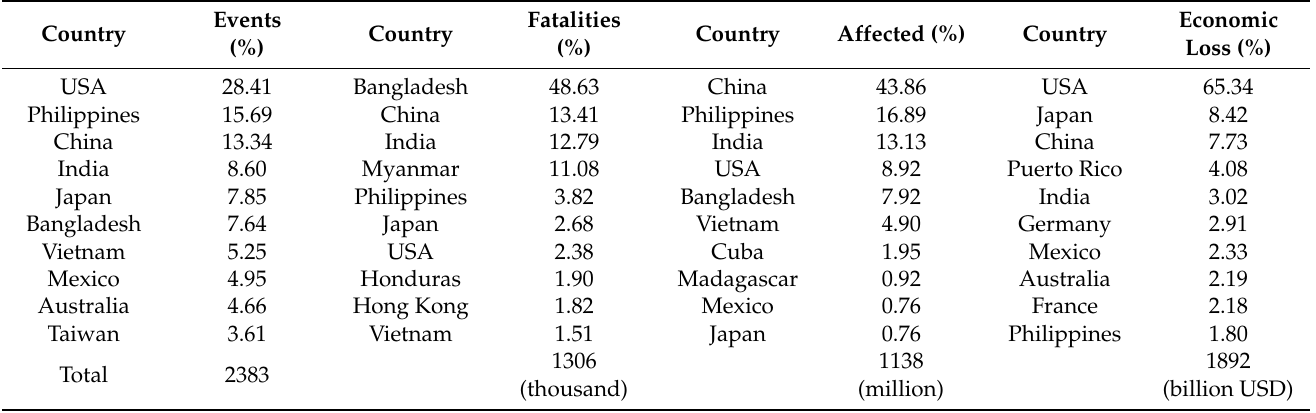
Table 3. Distribution of events, fatalities, affected people, and economic loss in top 10 countries due to meteorological disasters (storms only) from 1900 to 2020 AD. (Data Source: [57]).